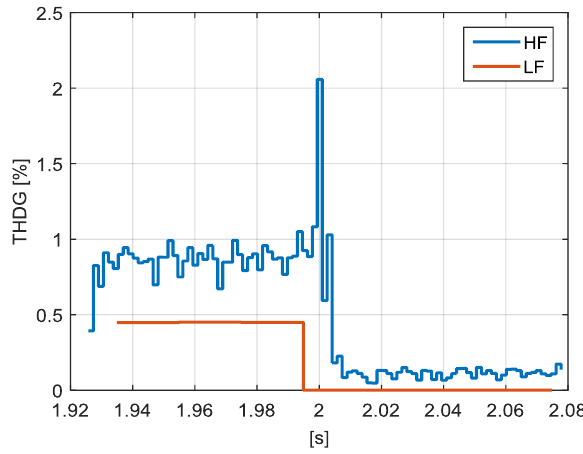
Figure 45. Case study 3: THDG at low-frequency (0 ÷ 2.4 kHz, red line) and at high-frequency (2.4 ÷ 150 kHz, blue line).